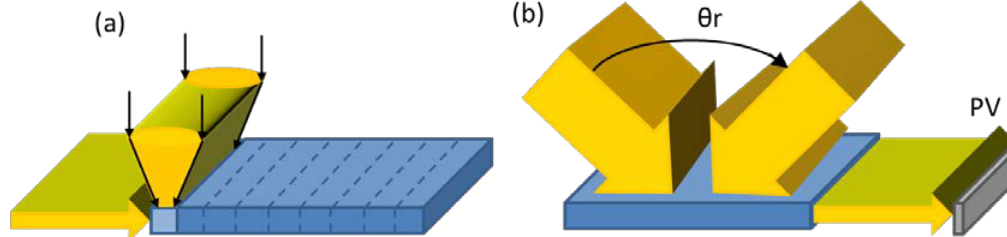
Appl. Sci. 2019 , 9 , 193 Figure 5. ( a ) Recording set-up and ( b ) configuration of volume holographic concentrator [56].